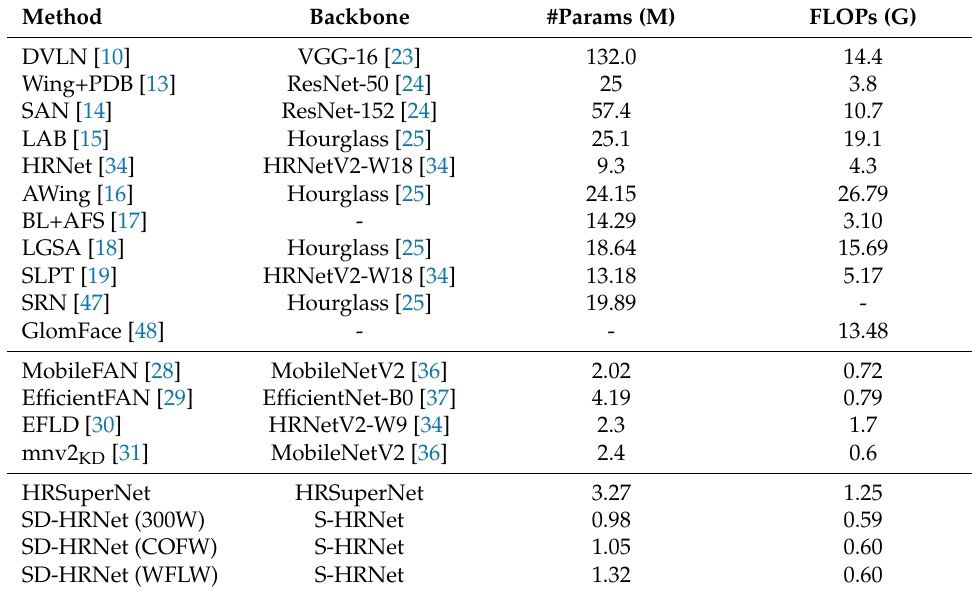
Table 1. Comparison of different methods in backbone, #Params, and